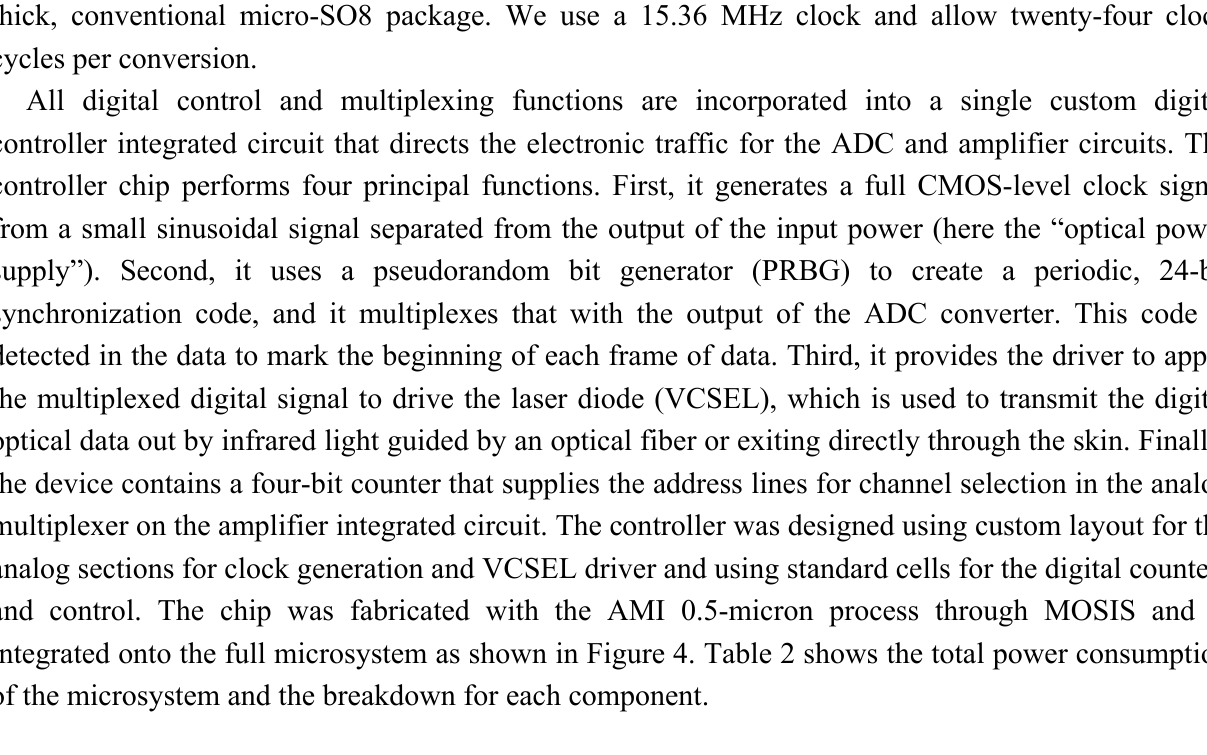
Table 2. Breakdown of Power Dissipation in the